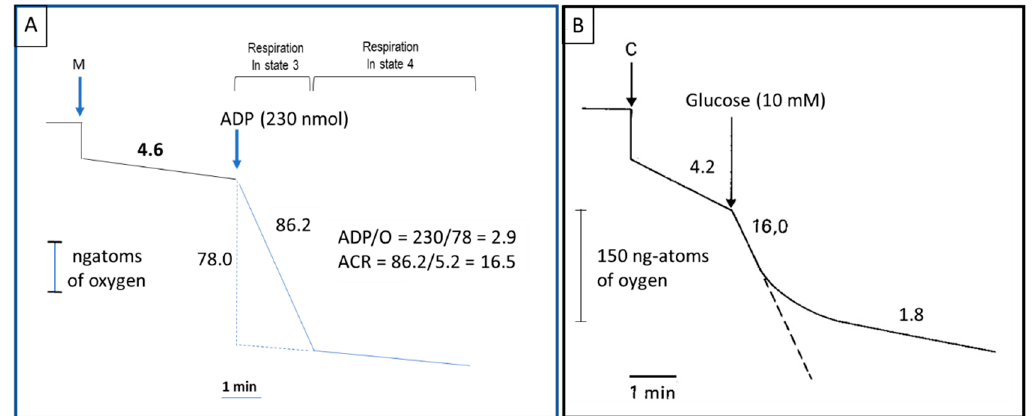
Figure 1. Respiratory control ( A ) and oxidative phosphorylation ( B ) of the mitochondria isolated from hepatocarcinoma ascites AH130. ACR, acceptor control ratio. C, cells, M, mitochondria.